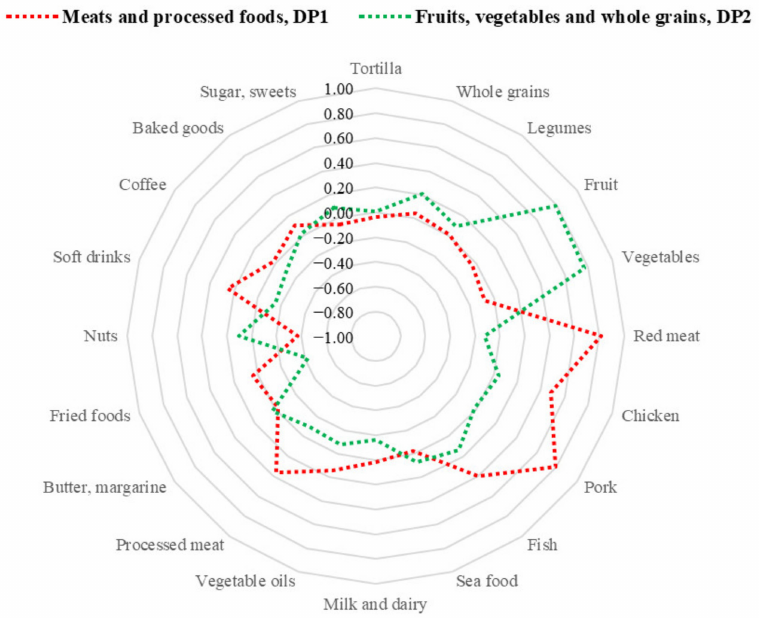
Figure 2. Radar plot of factor loadings of the main dietary patterns identified in Mexican